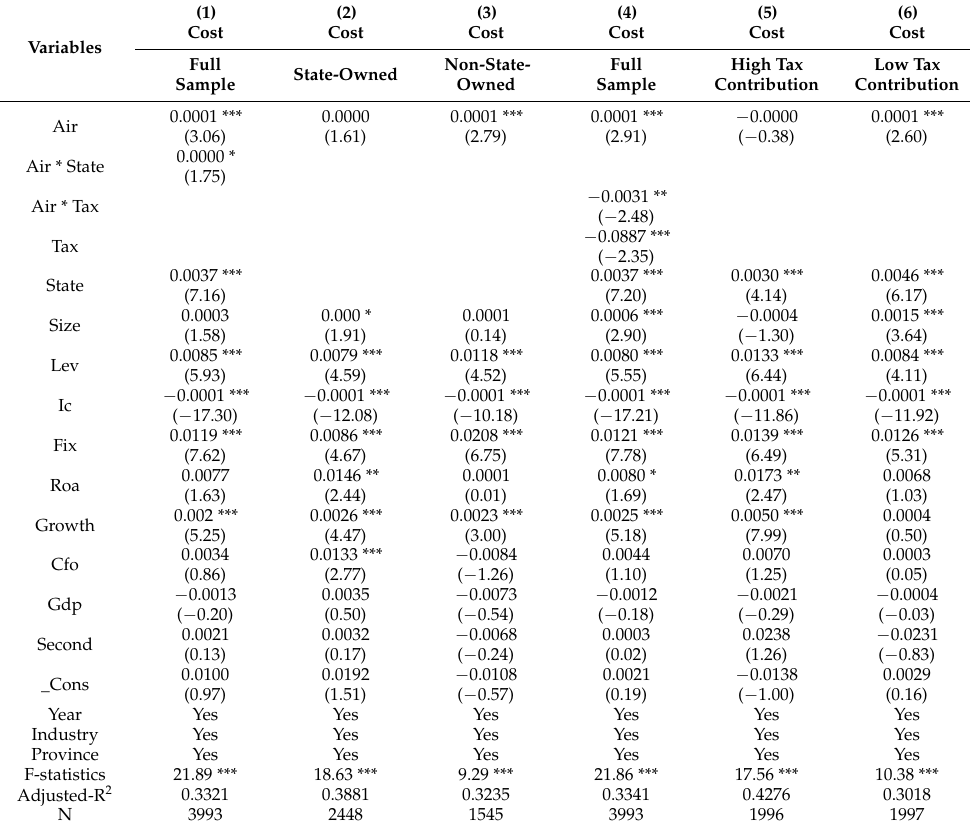
Table 12. Moderating effect of firm’s ownership and economic